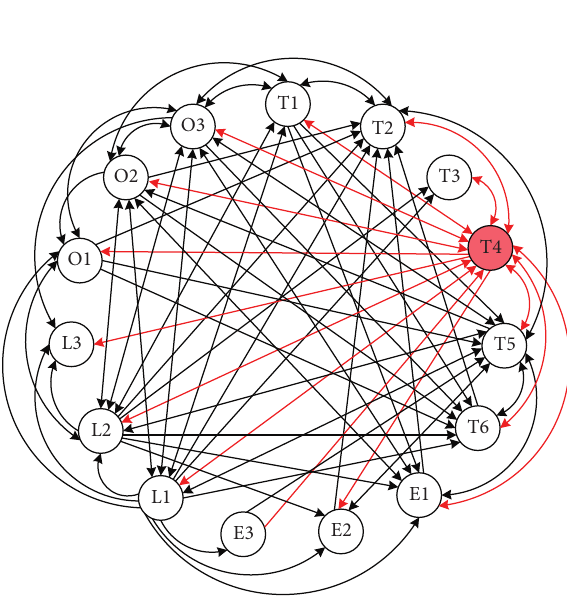
Figure 5: The initial diagram among various